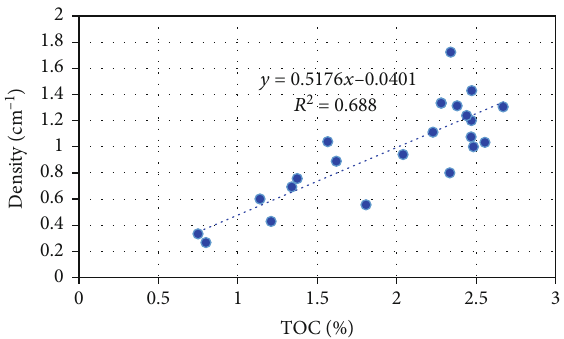
Figure 6: Relationship between density of lamellation fractures and TOC content in the Qianjiang Depression.